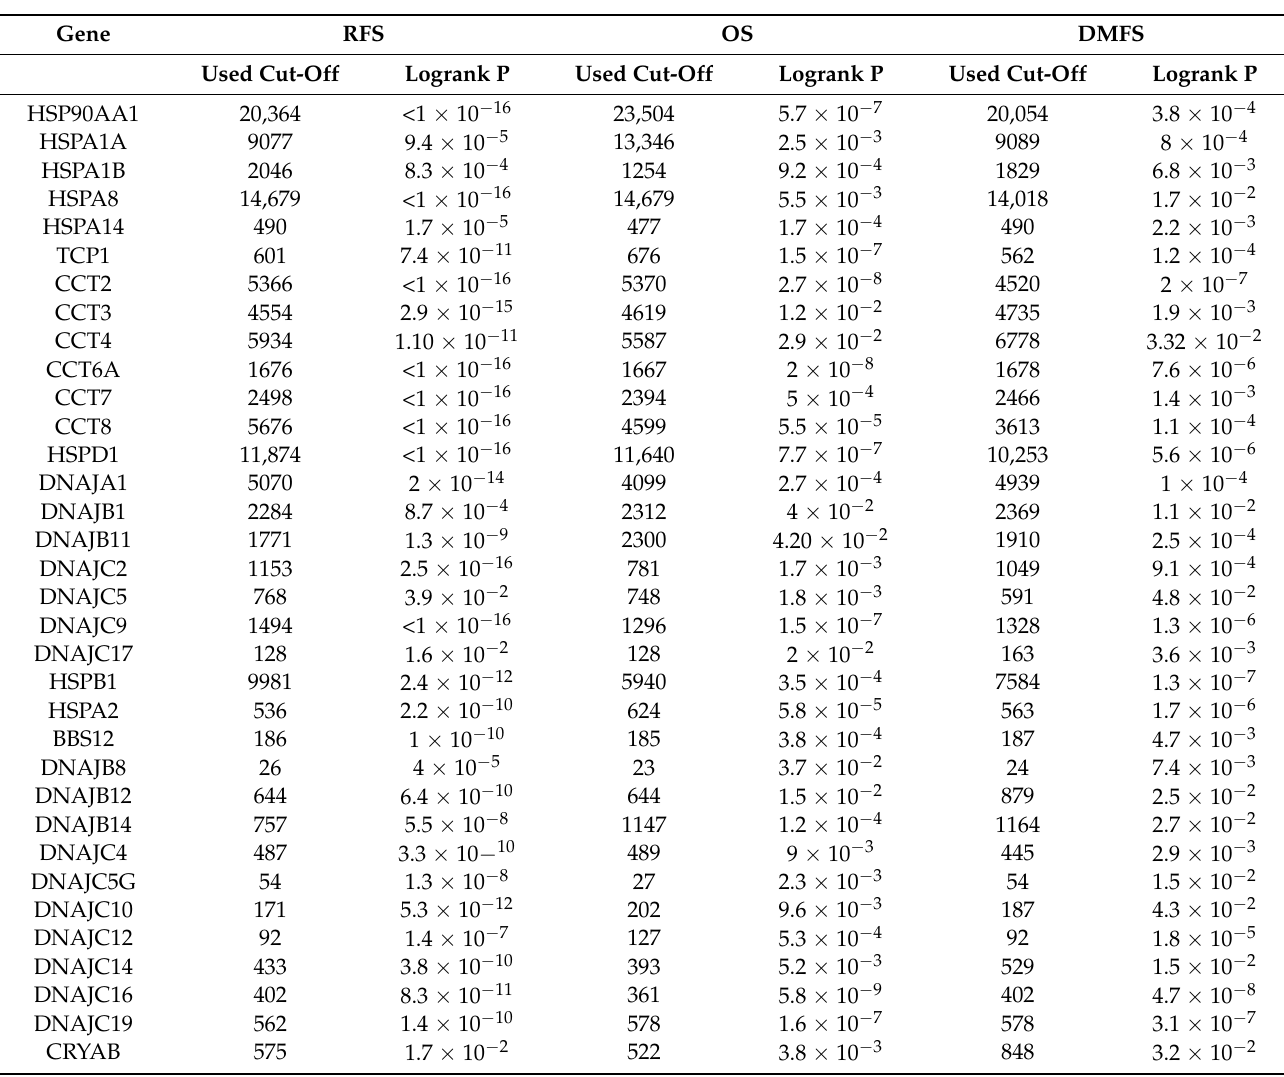
Table 3. List of HSP members significantly associated with clinical outcome, including Relapse Free Survival (RFS), Overall Survival (OS), and Distant Metastasis Free Survival (DMFS), evaluated by KM Plotter database. The Log Rank value was marked in red when higher expression of selected HSP was associated with poor prognosis and in the black when higher expression of selected HSP was associated with a good prognosis. The probe expression value cut-off for each analysis is also